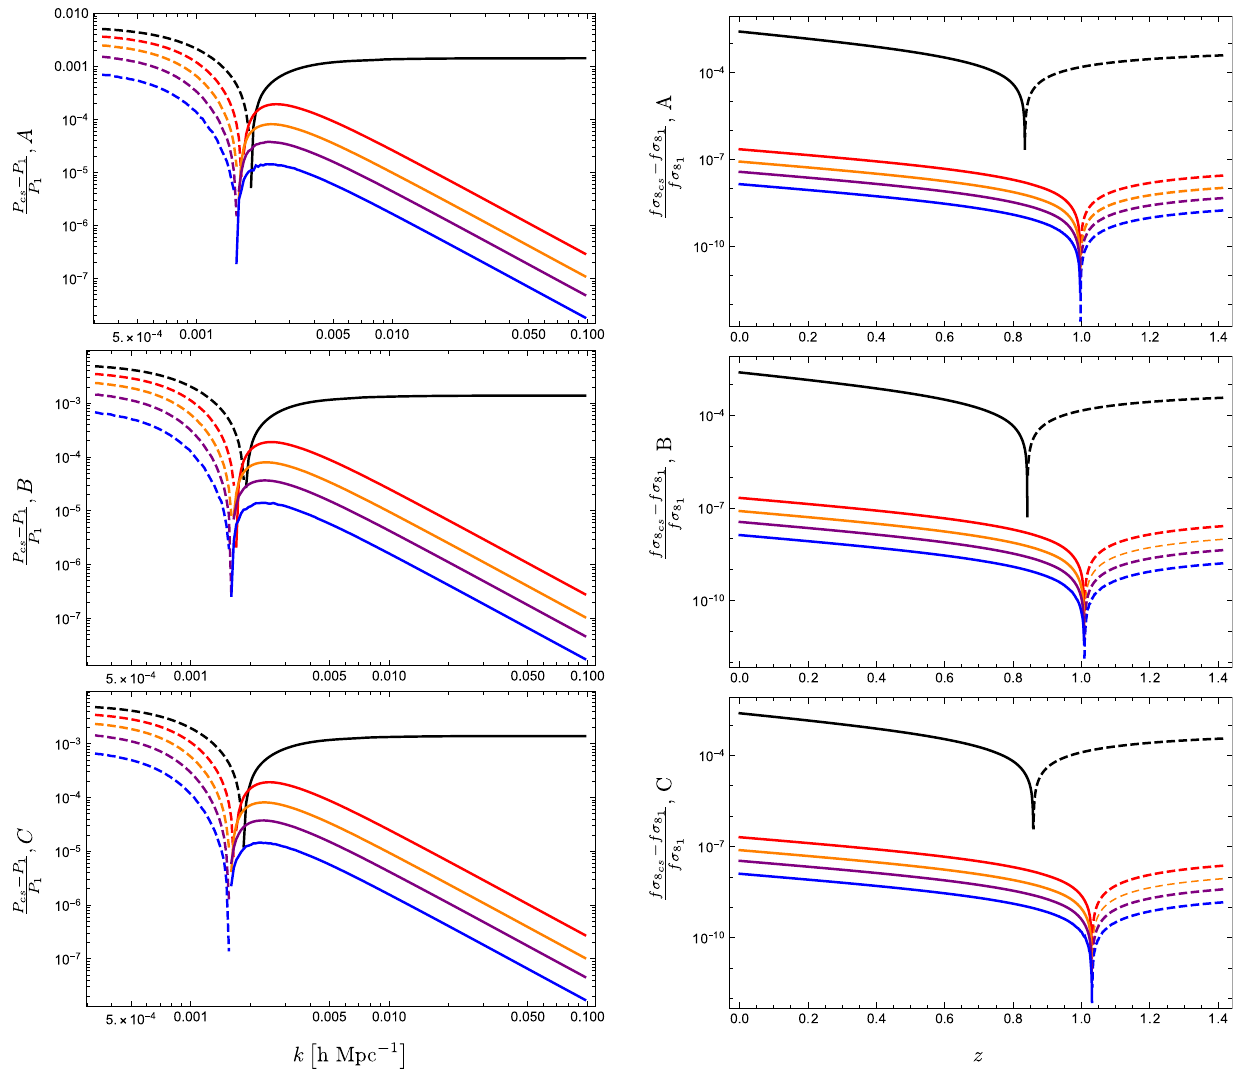
= 0(black), c 2 = 0 . 2(red), c 2 = 0 . 4 arecolouredas; c 2 valuesof c 2 s d s d s d s d = 0 . 6 (purple) and c 2 = 0 . 8 (blue). The plots are repre- (orange), c 2 s d s d sented in a logarithmic scale, in such a way that dashed lines correspond with negative values while solid lines represent positive